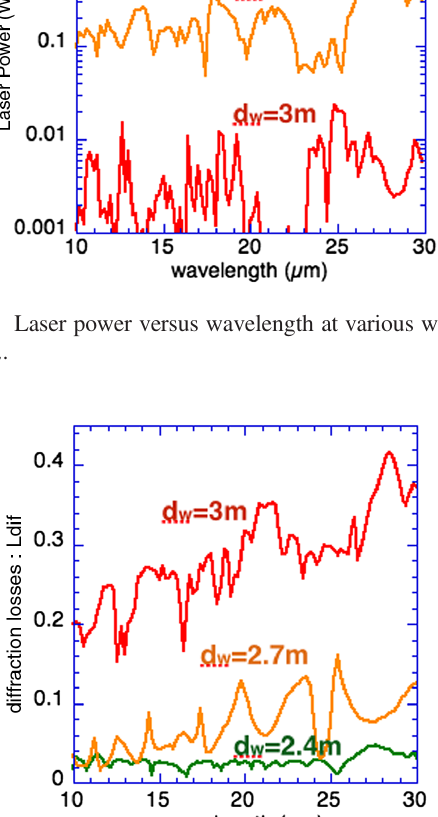
versus wavelength at various dif . w